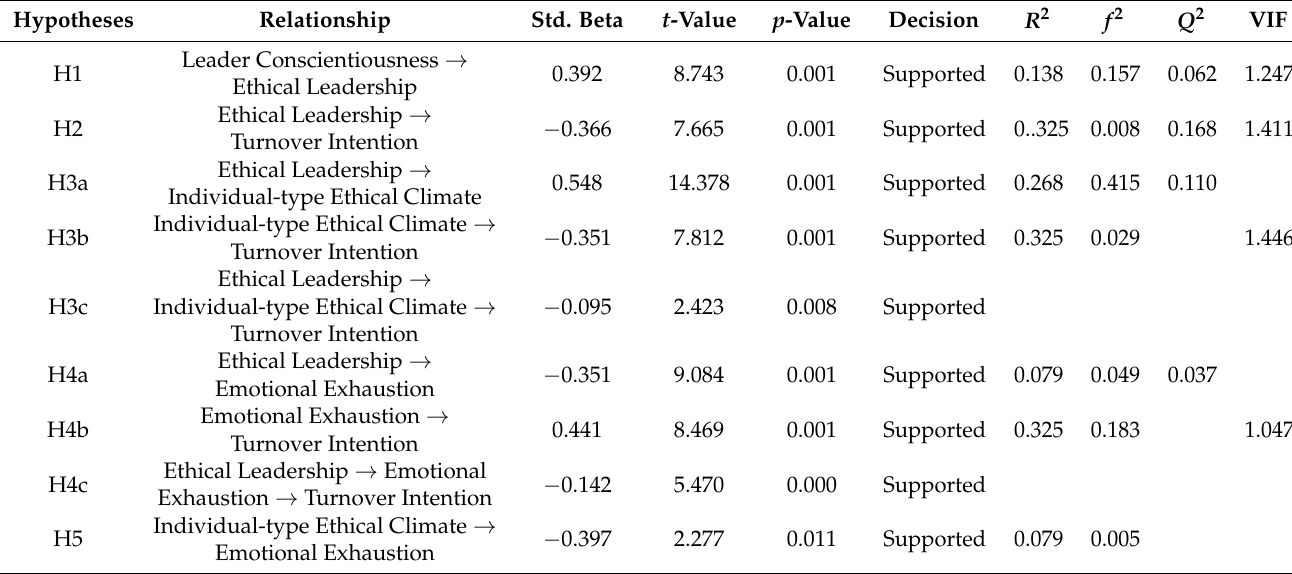
Table 5. Structural model